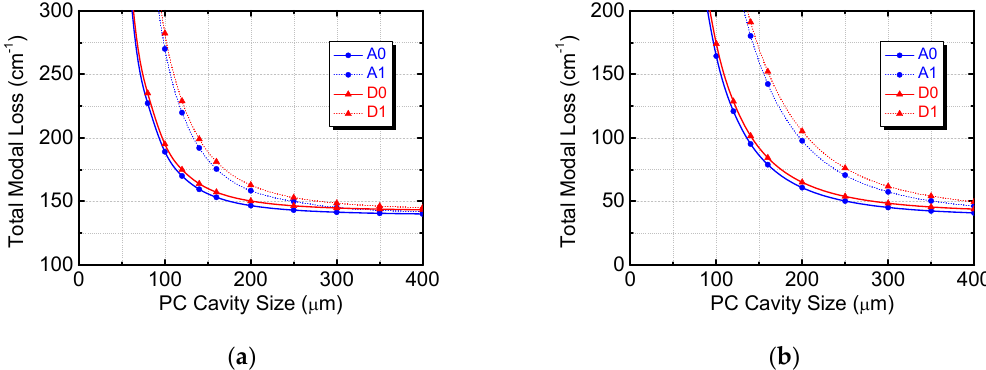
Figure 9. Finite cavity with CC design ( f 1 , f 2 , ∆ ) = (0.15, 0.05, a /3): the total modal losses of the two lowest fundamental modes as well as associated first high-order modes as a function of PC cavity size for ( a ) air-hole and ( b ) air-pillar PC-SELs.